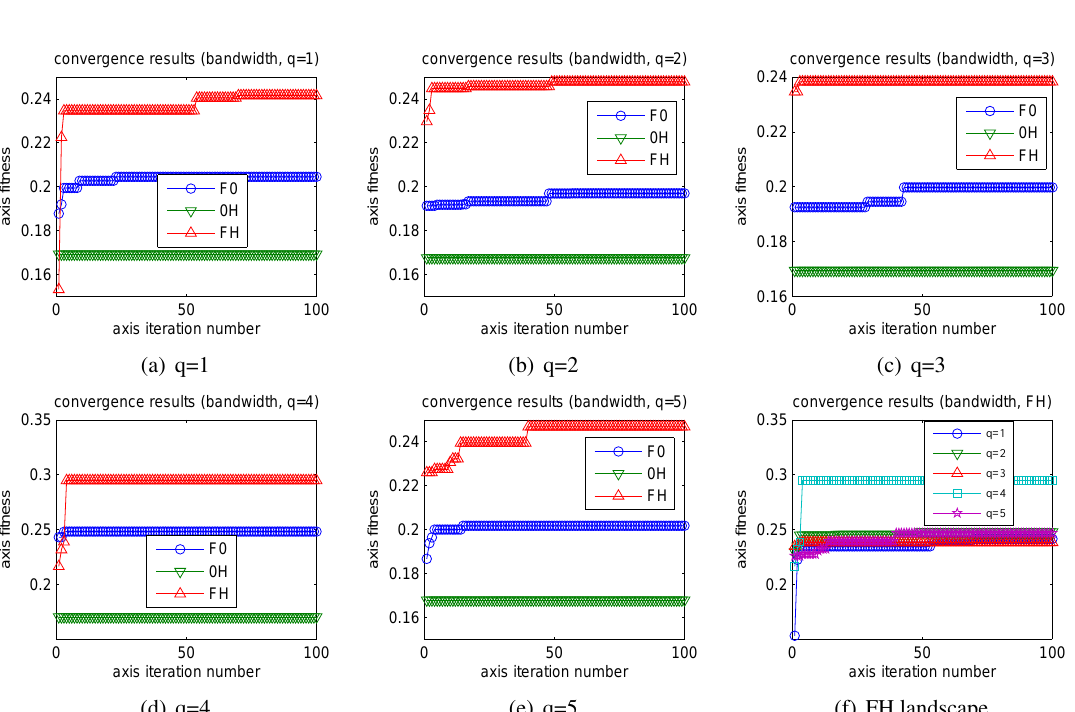
Figure 8: Optimizing time.